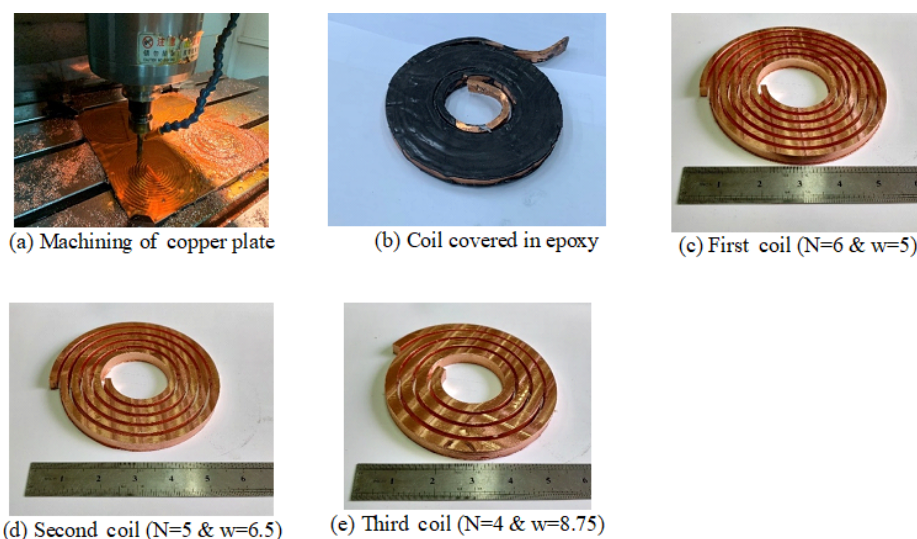
Figure 6. (a) Manufacturing of the coil on the CNC milling machine and (b) coil gap covered in epoxy. (c–e) Varying sizes of coils used in the